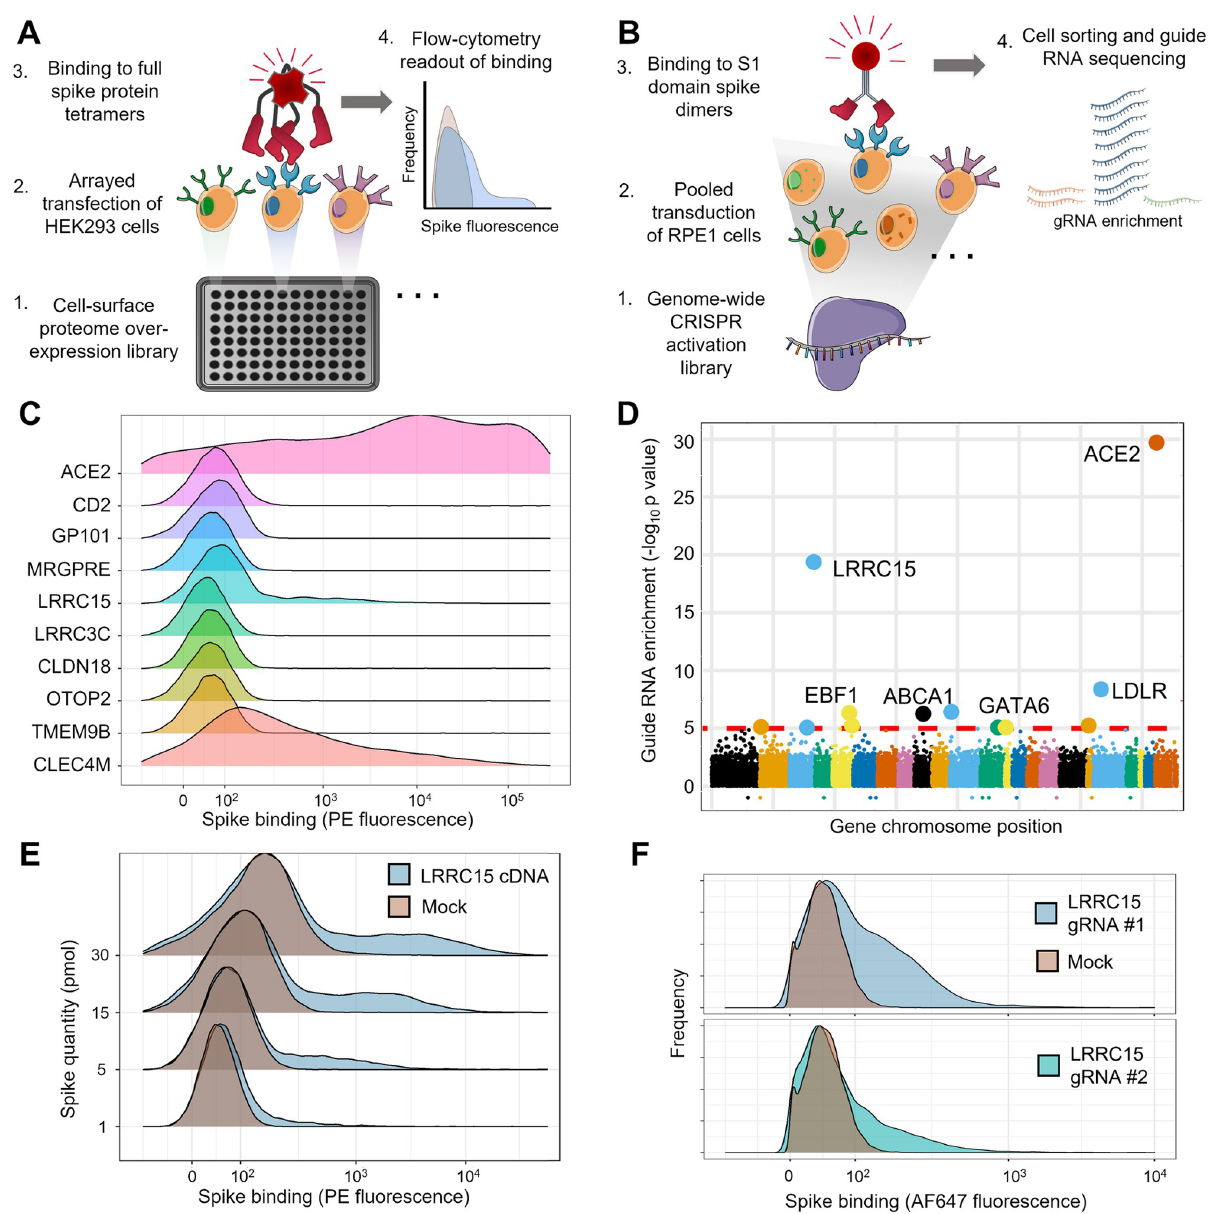
Fig 1. Arrayed transmembrane protein screening and pooled genome-wide CRISPR activation screening identify LRRC15 as binding SARS-CoV- 2 spike protein. ( A ) Schematic of arrayed cell-based screening to identify host factors that cause SARS-CoV-2 spike protein binding. HEK293 cells were transfected in individual wells of microtiter plates with full-length cDNA constructs encompassing a near-comprehensive library of human membrane proteins. Each well in the array was tested for binding to fluorescent tetramers of full-length SARS-CoV-2 spike by flow cytometry. ( B ) Schematic of pooled CRISPR activation screening. RPE1 cells expressing a SunTag CRISPRa system were transduced with guide RNAs to activate transcription of all genes in the human genome. Cells that bound to Fc protein fusions of the spike S1 domain were sorted by FACS and sequenced to measure guide RNA enrichment. ( C ) Top-ranked hits from arrayed cDNA screening. Distributions of cell fluorescence by flow cytometry are shown after incubation with fluorescent spike protein tetramers for cDNAs, which produced top-ranked signals in the arrayed screen. CD2 is included as a negative control. ( D ) Guide RNA enrichment of genes promoting SARS-CoV2 spike protein binding using CRISPR activation screening. Genes are ordered according to their positions across the genome and the statistical significance of their respective guide RNA enrichments post-sorting. ( E ) Independent transfections of LRRC15 cDNA induce spike binding. Flow cytometry traces for HEK293 cells transiently transfected with LRRC15 cDNA compared to mock- transfected controls. Different quantities of full-length spike protein were applied, as indicated along the y-axis. ( F ) Single-guide RNA clones validate LRRC15 as a gene that induces spike binding. Flow cytometry traces for RPE1 cells transduced and selected for individual LRRC15-activating guide RNAs. CRISPRa, CRISPR activation; LRRC15 AU : AbbreviationlistshavebeencompiledforthoseusedinFigs 1 (cid:0) 4 ; attheendofeachfigurecaption : Pleaseverifythatallentriesarecorrect : , leucine-rich repeat containing protein 15; SARS-CoV-2, Severe Acute Respiratory Syndrome Coronavirus